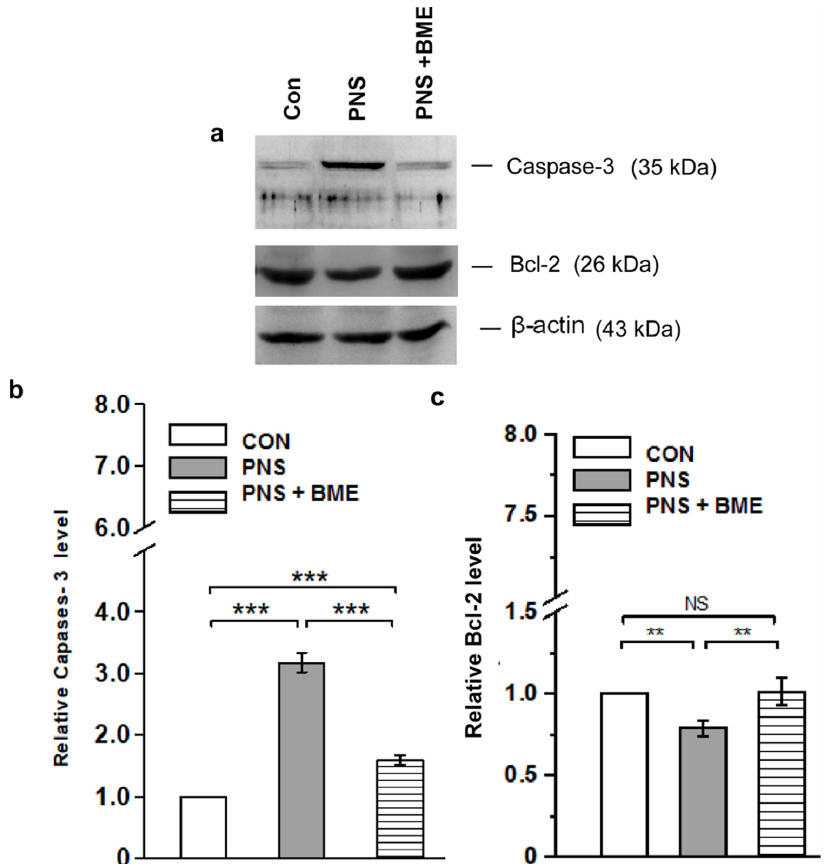
Figure 6. Effect of exposure to BME treatment on PNS-induced changes on caspase-3 and Bcl-2 level in amygdale. ( a ) Representative Western blot showing that the levels of caspase-3 and Bcl-2 varied across the experimental groups. Quantitative estimation of caspase-3 ( b ) and Bcl-2 ( c ) showing that exposure to BME treatment induces an opposite pattern of expression. Data are expressed as mean ± SEM ( n = 6/group). One-way ANOVA followed by Bonferroni post hoc test (for all pairwise multiple comparisons, statistical significance is indicated by ** p < 0.01 and *** p < 0.001; NS—Not significant).